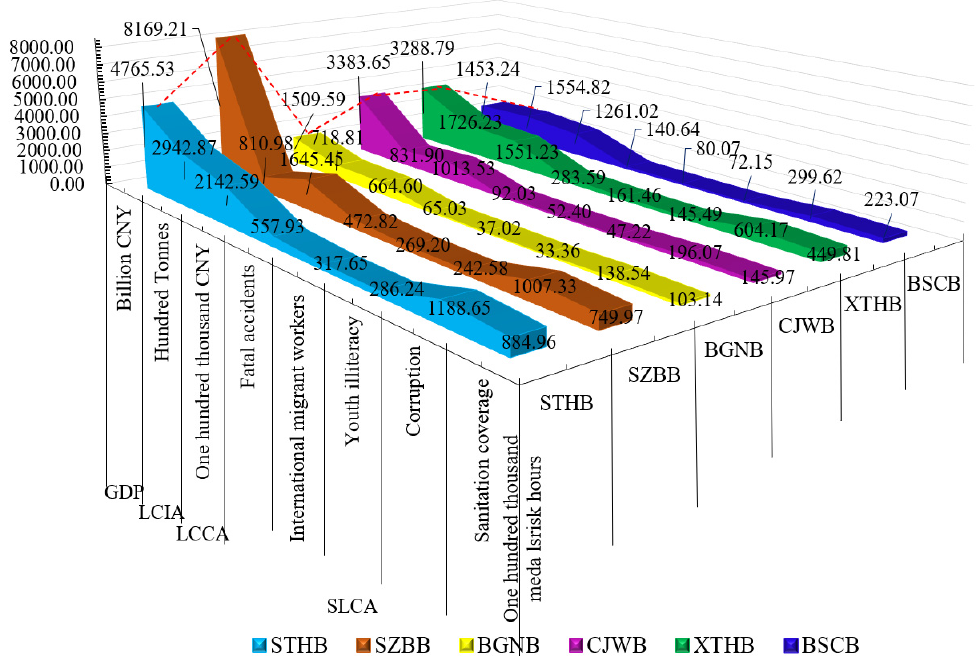
Figure 9. Schematic diagram of gross domestic product (GDP) [96], LCIA, LCCA, and SILA data in the area where the six cable-stayed bridges are located.